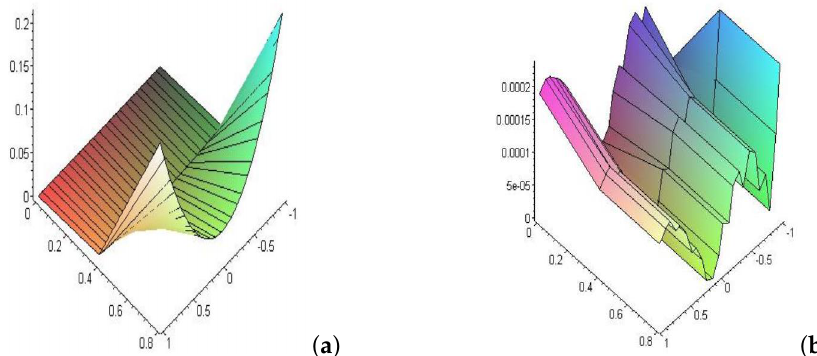
Figure 1. ( a ) Shows the corresponding error of NMIE with a logarithmic kernel at different times, whereas ( b ) illustrates the corresponding error for the linear case at the same times.